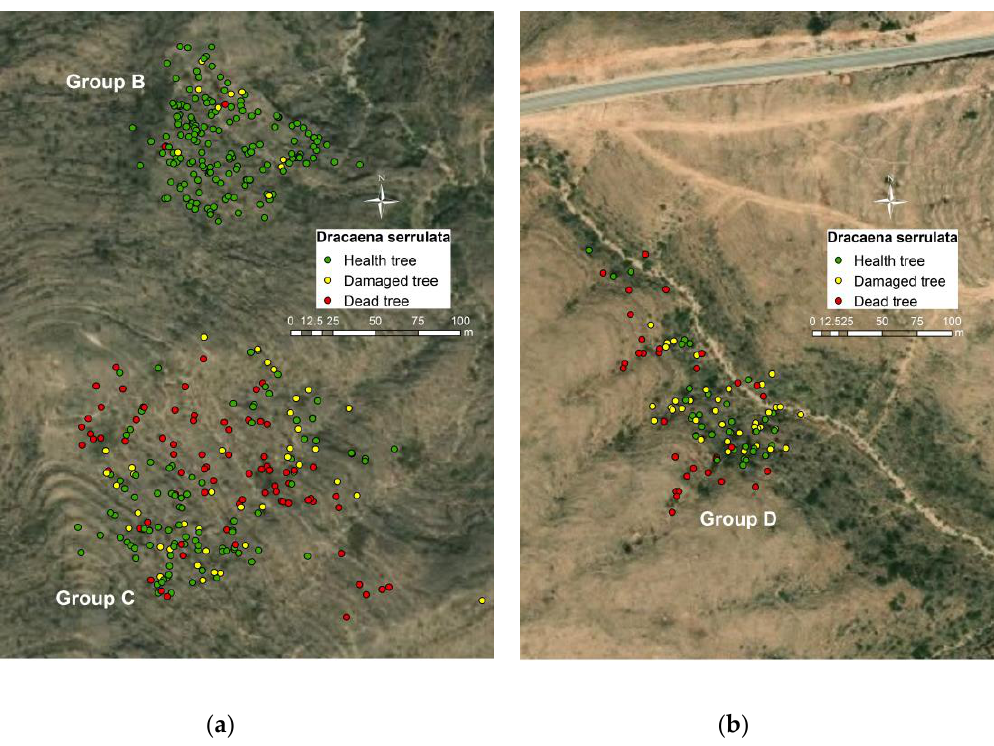
Figure 8. ( a ) Inventory of groups B and Cat the eastern part of Jabal al Qamar. ( b ) Inventory of group D at the west part of Jabal al Qamar. Background: ESRI basemaps (Redlands, CA, USA).